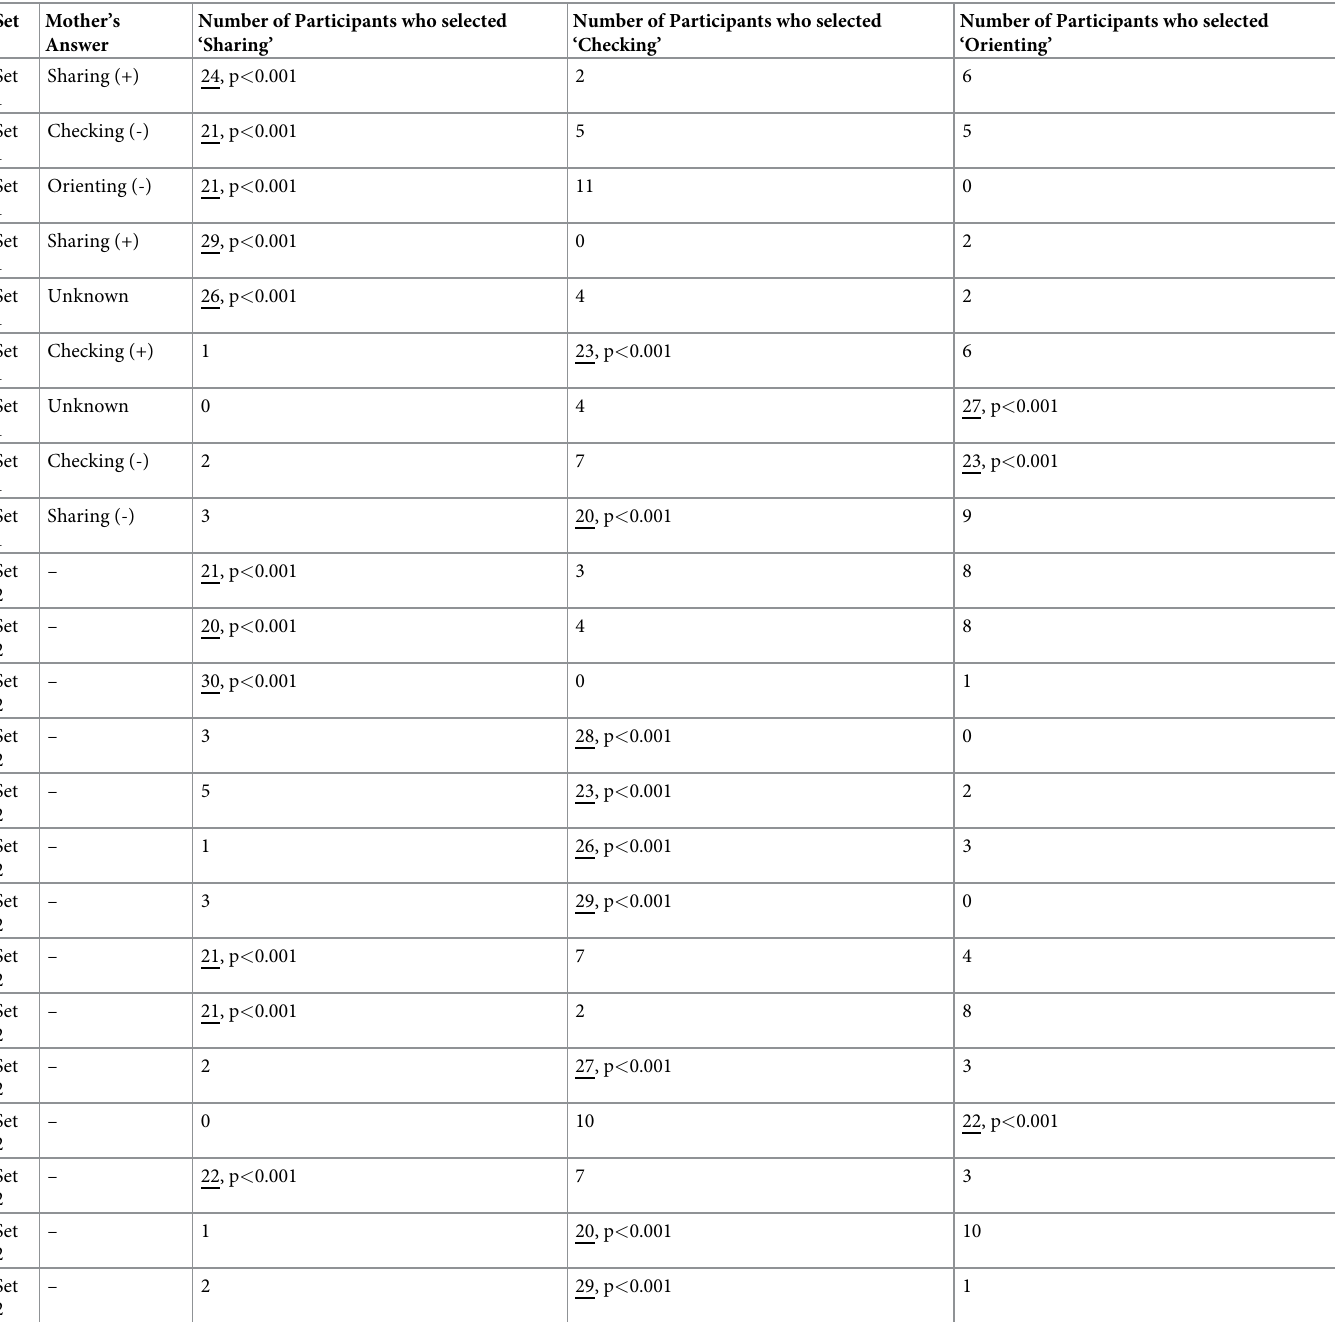
Table 3. Distribution of participant responses over the three categories of looks for the 23 looks identified as ‘high agreement’ by binomial